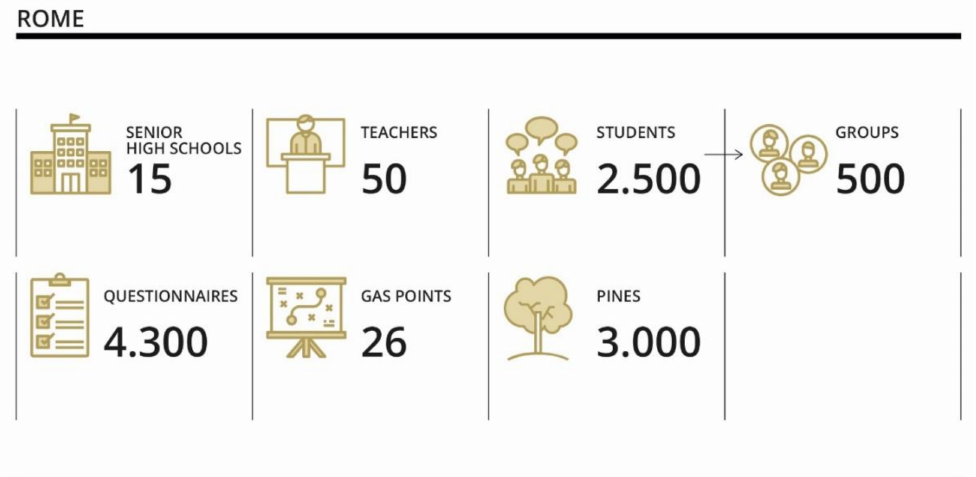
Figure 2. The rationale of this study is re-examining old projects and reliving significant messages for current CS activities. Project #2 was run in five districts of Rome and 1 at Pomezia over the 1984/85 school year. It analyzed two aspects of the industrial civilization: the final uses of energy in private houses that are familiar uses, including final uses in the respective building types, and urban pollution gases. (For ease of reading, groups of thousands are divided into digit groups using a dot